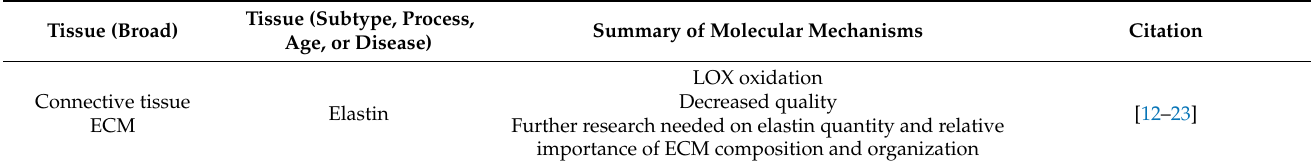
Table 1. Summary of age-dependent molecular effects on optic nerve (ON) neurodegeneration. Tissue (Subtype, Process, Tissue (Broad) Age, or